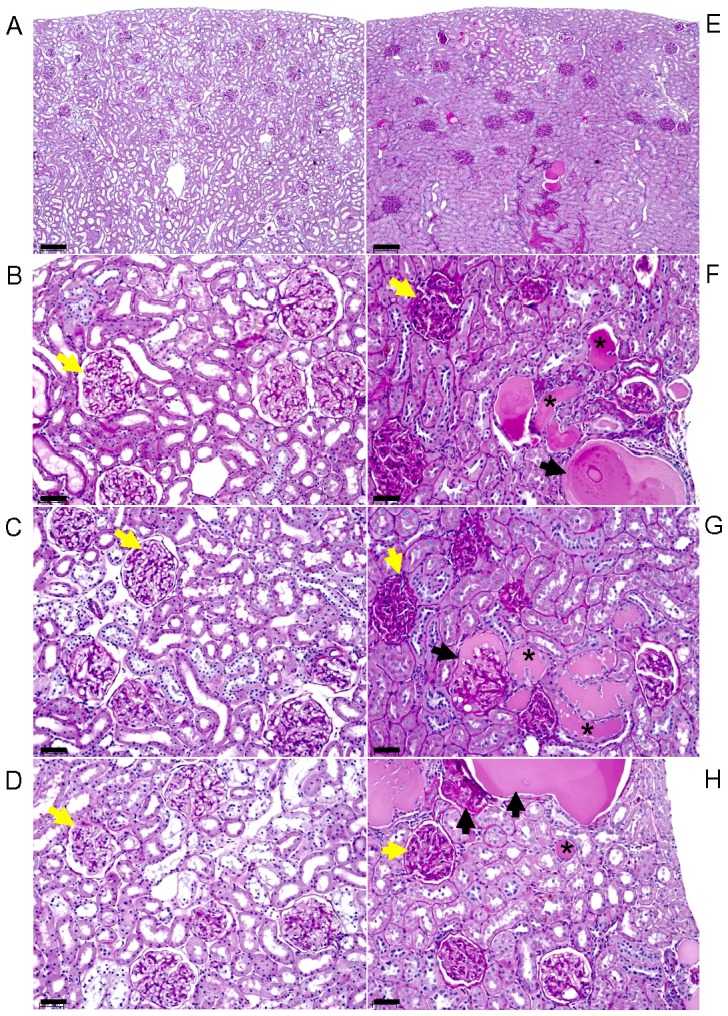
Representative Periodic Acid Schiff (PAS)-stained photomicrographs of rat kidneys with low (≤115) and high (≥265) glomerular injury scores (GIS).A. Low magnification view of representative rat kidney section with low GIS, and (B–D) high magnification view of three representative rat kidney sections with low GIS scores demonstrate mild PAS-staining (magenta) of glomerular mesangial matrix and basement membranes, minimal PAS-staining of tubular basement membranes and tubular casts, and no glomerular sclerosis. In contrast, E, low magnification view of representative rat kidney section with high GIS, and (F–H) high magnification view of three representative rat kidney sections with high GIS show increased number of PAS-stained glomeruli with thickened mesangial matrix and basement membranes, glomerular sclerosis, tubular casts and PAS-stained thickened tubular basement membranes. Yellow <$>\raster(80%)="rg1"<$>, glomeruli, <$>\raster(80%)="rg1"<$> sclerotic glomeruli, *, tubular casts, bar = 200 micron (A, E), 50 microns (B–D, E–H).